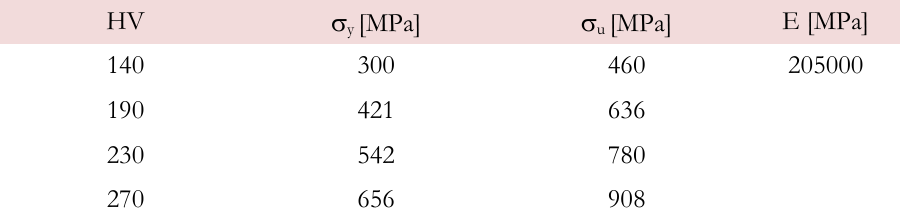
Table 1: Hardness measurements and related mechanical properties.